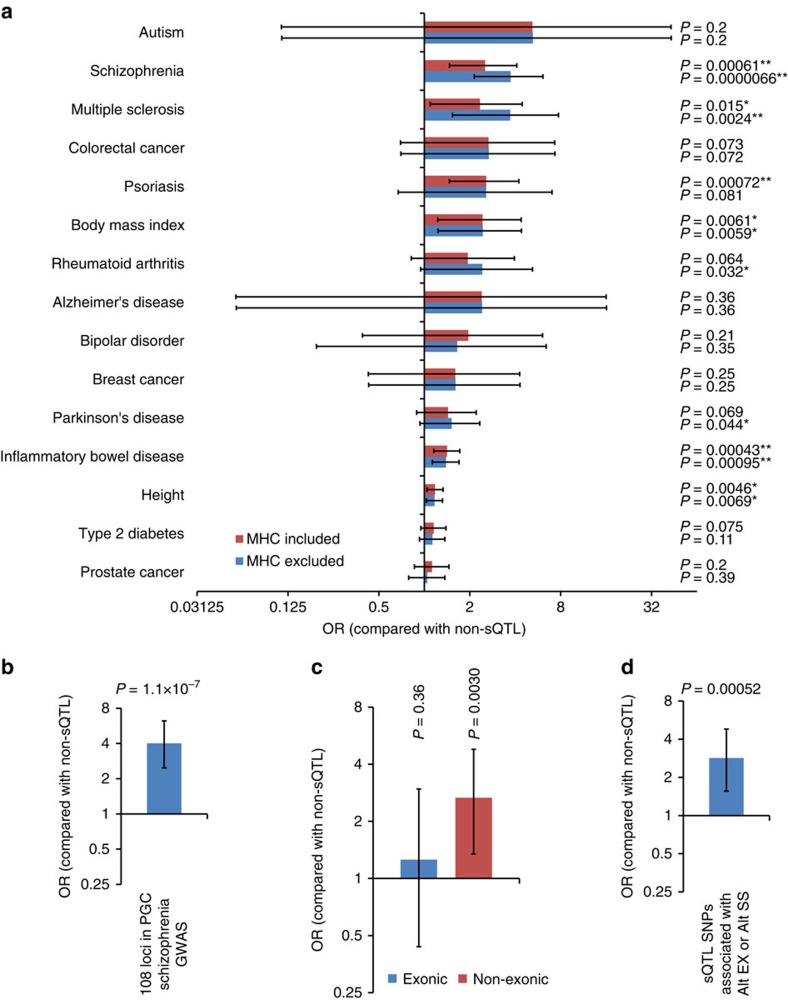
Enrichment analyses of sQTL SNPs among disease-associated loci.(a) Results of enrichment analyses of sQTL SNPs among loci associated with 15 diseases/traits (nine diseases with the largest numbers of genome-wide significantly associated SNPs in the GWAS Catalog23: breast cancer, colorectal cancer, inflammatory bowel disease, multiple sclerosis, prostate cancer, psoriasis, rheumatoid arthritis, schizophrenia and type 2 diabetes; four additional brain disorder groups: autism, Alzheimer's disease, bipolar disorder, Parkinson's disease; and two most intensively investigated non-disease traits: height and body mass index). Red and blue bars indicate the results from analyses including and excluding variants in the MHC locus, respectively. Results are shown in the order of OR from the analyses excluding MHC variants. Uncorrected P-values calculated by one-tailed Fisher's exact test are shown. *P<0.05 and **P<0.05/15=0.0033 (corresponding to the significance threshold considering the number of diseases/traits tested). (b) An enrichment analysis using the data of PGC GWAS instead of the data based on the GWAS Catalog. (c) Enrichment analyses dividing SNPs into exonic and non-exonic variants. (d) An enrichment analysis excluding sQTL SNPs associated with IRs. P-values were calculated by one-tailed Fisher's exact tests. Bars indicate 95% confidence intervals.